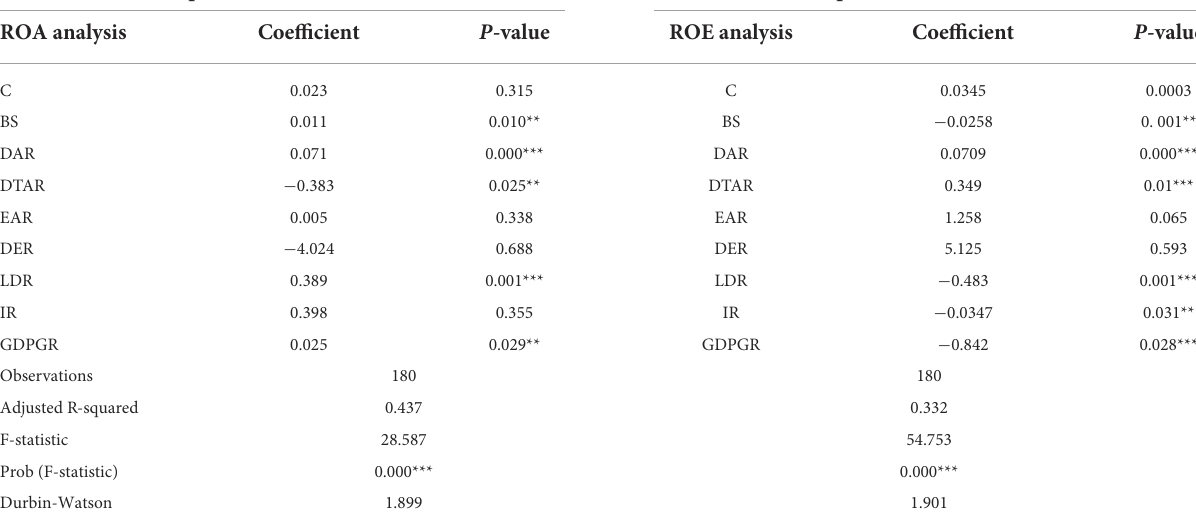
TABLE 10 Bangladesh’s bank profitability regression results using Random Effects Estimation (measured by ROA and ROE).